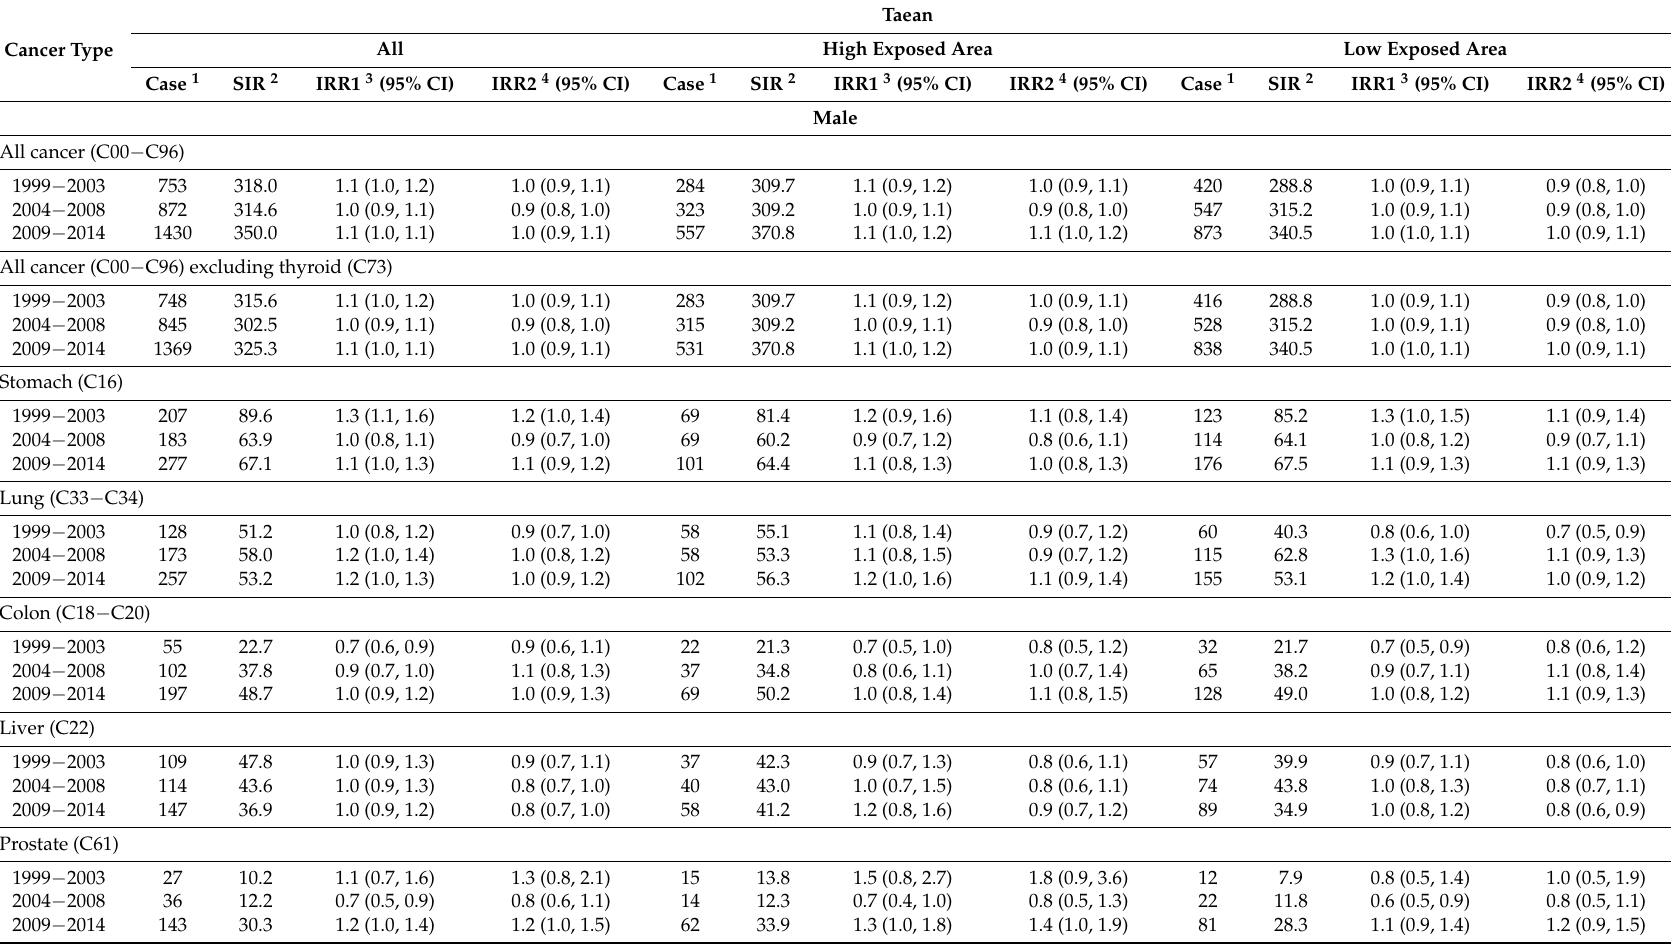
Table 1. Age-standardized incidence rate and incidence rate ratio of five major cancers and leukemia according to the Hebei Spirit oil spill exposure areas in Taean, Korea, 1999 − 2014.